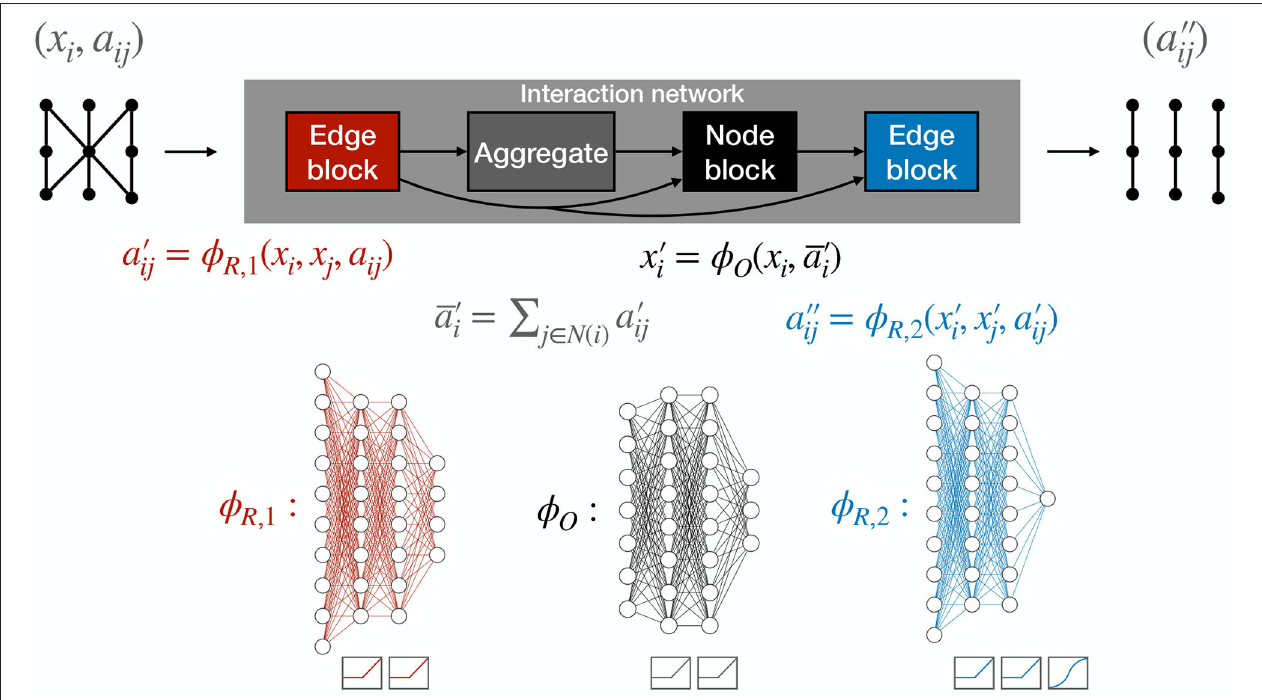
FIGURE 5 | The complete IN forward pass with the edge, edge-aggregation, and node blocks. The functions φ R ,1 , φ R ,2 , and φ O are multilayer perceptrons (MLPs) with rectified linear unit (ReLU) activation functions on the hidden layers. In addition, the φ R ,2 outputs have a sigmoid